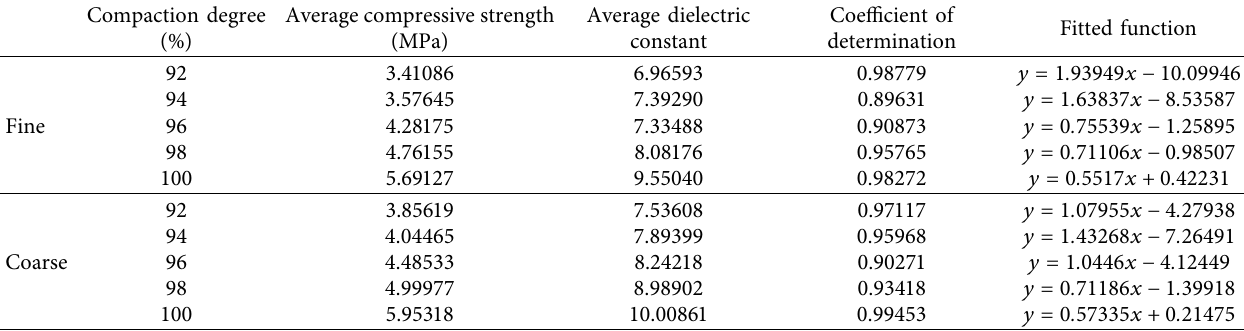
Table 3: Relationship between the dielectric constant and strength of CSMB specimens.